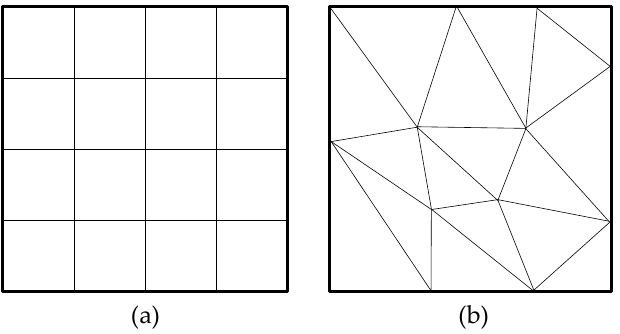
Figure 1. Different data representation between the digital elevation model (DEM) ( a ) and triangulated irregular (TIN) ( b ). DEM is raster data, while TIN is irregular triangular data.